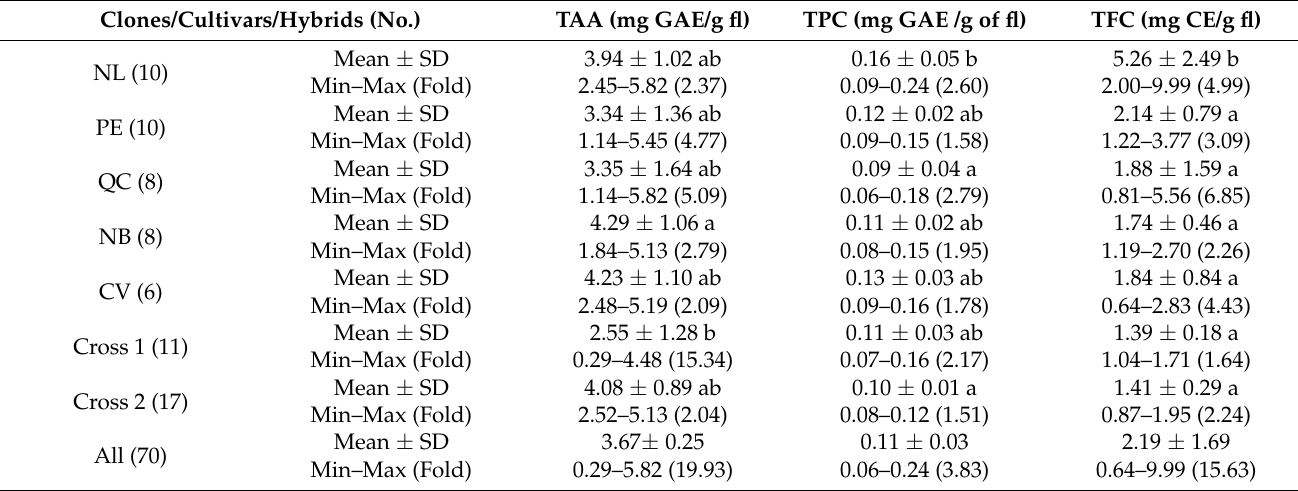
Table 3. Total antioxidant activity (TAA), phenolic (TPC) and flavonoid contents (TFC) of groups of wild clones collected from four Canadian provinces: Newfoundland and Labrador (NL), Prince Edward Island (PE), Quebec (QC), and New Brunswick (NB). Cultivars (CV): Fundy, Polaris, Patriot, Chippewa, St. Cloud, Northblue (NOB); hybrids: Cross 1 and Cross 2. GAE = gallic acid equivalent; CE = catechin equivalent; fl = fresh leaf. Clones/Cultivars/Hybrids